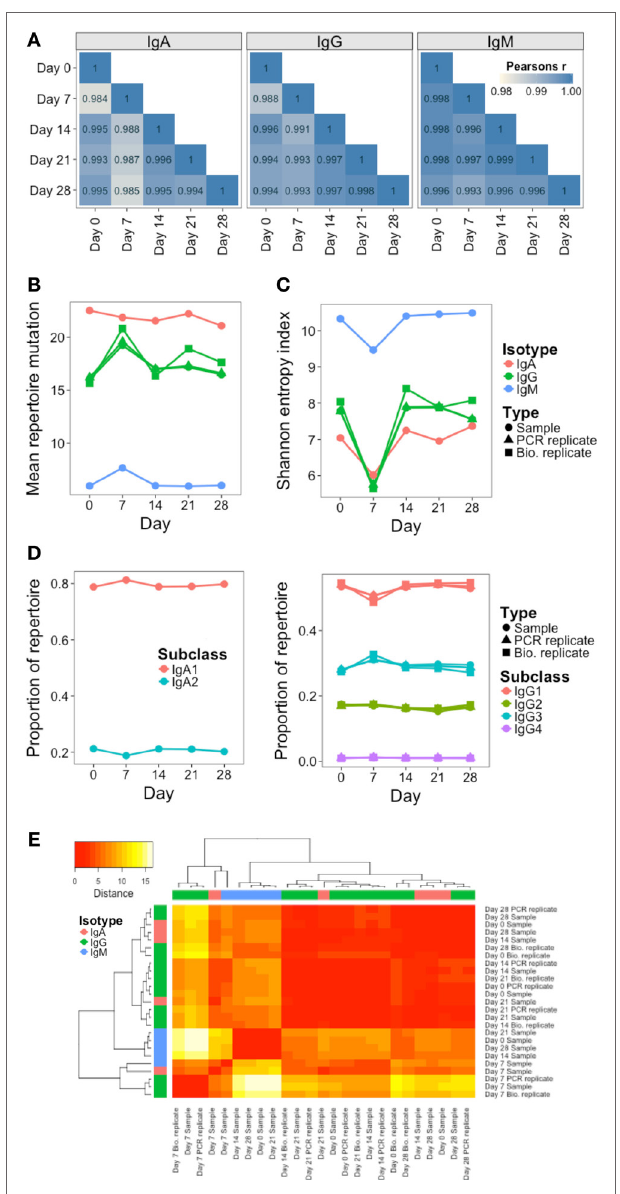
FigUre 5 | Persistence of global repertoire properties over time . (a) Correlation in relative usage proportion of each VJ gene combination from samples on different days from participant AF01. Stronger correlations are in darker blue. (B) Change in the mean number of V gene mutations of sequences in the repertoire over time. (c) Change in repertoire diversity over time, calculated using the Shannon entropy index, with each cluster represented as a distinct species. (D) Change in proportion of the repertoire comprised by sequences of the different IgA and IgG subclasses over time. (e) Euclidean distances between the diversity profiles of each sample were calculated, used for hierarchical clustering of the samples, and visualized as a heatmap. The color of the heatmap indicates the similarity in the profile between two samples (red = high similarity, white = low similarity). The color bars indicate the isotype of each